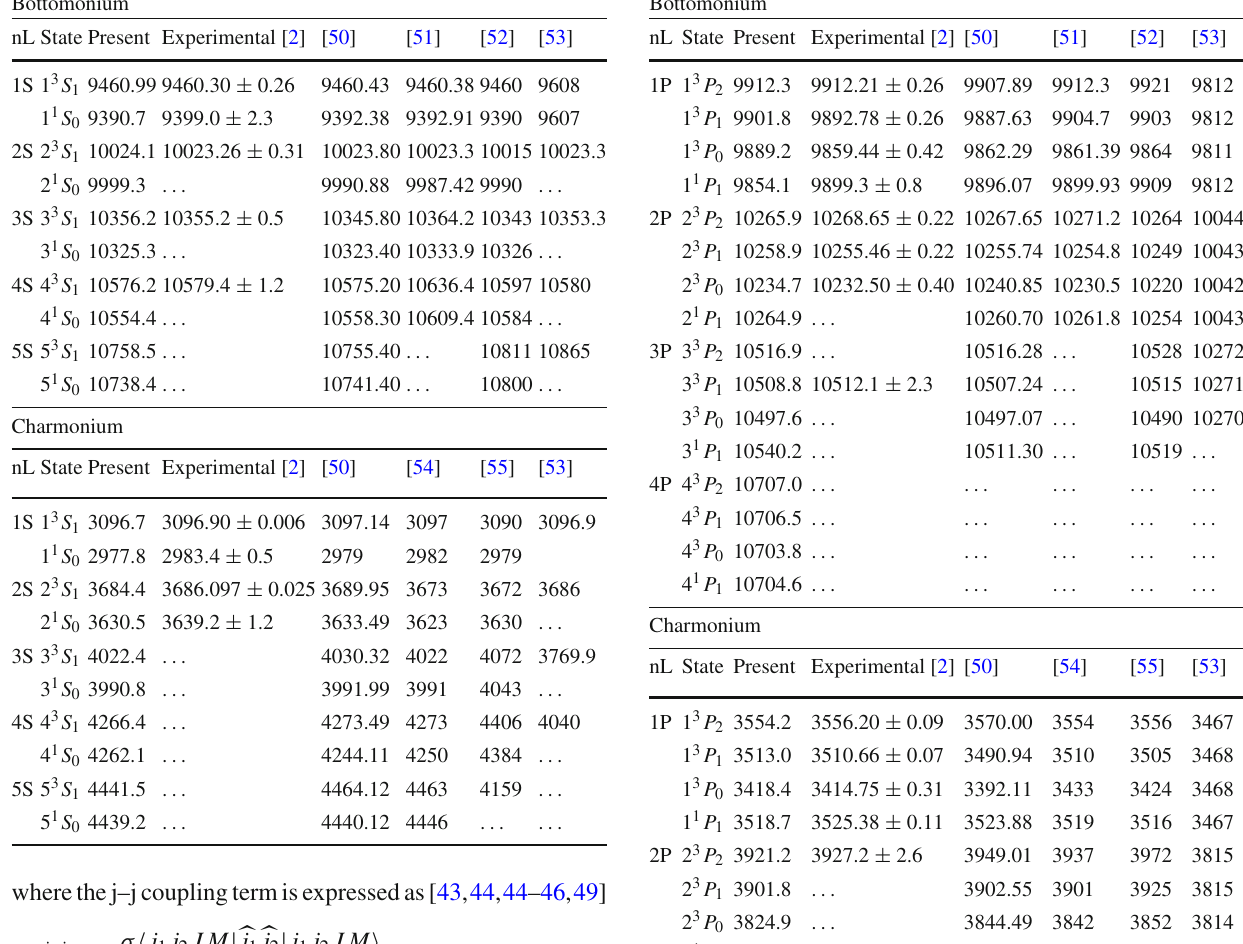
Table 3 S-wave mass spectrum for b ¯ b and c ¯ c bound states (in MeV) Bottomonium